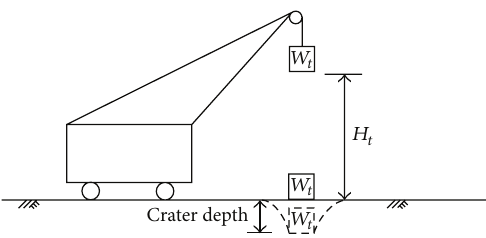
Figure 1: Schematic of dynamic